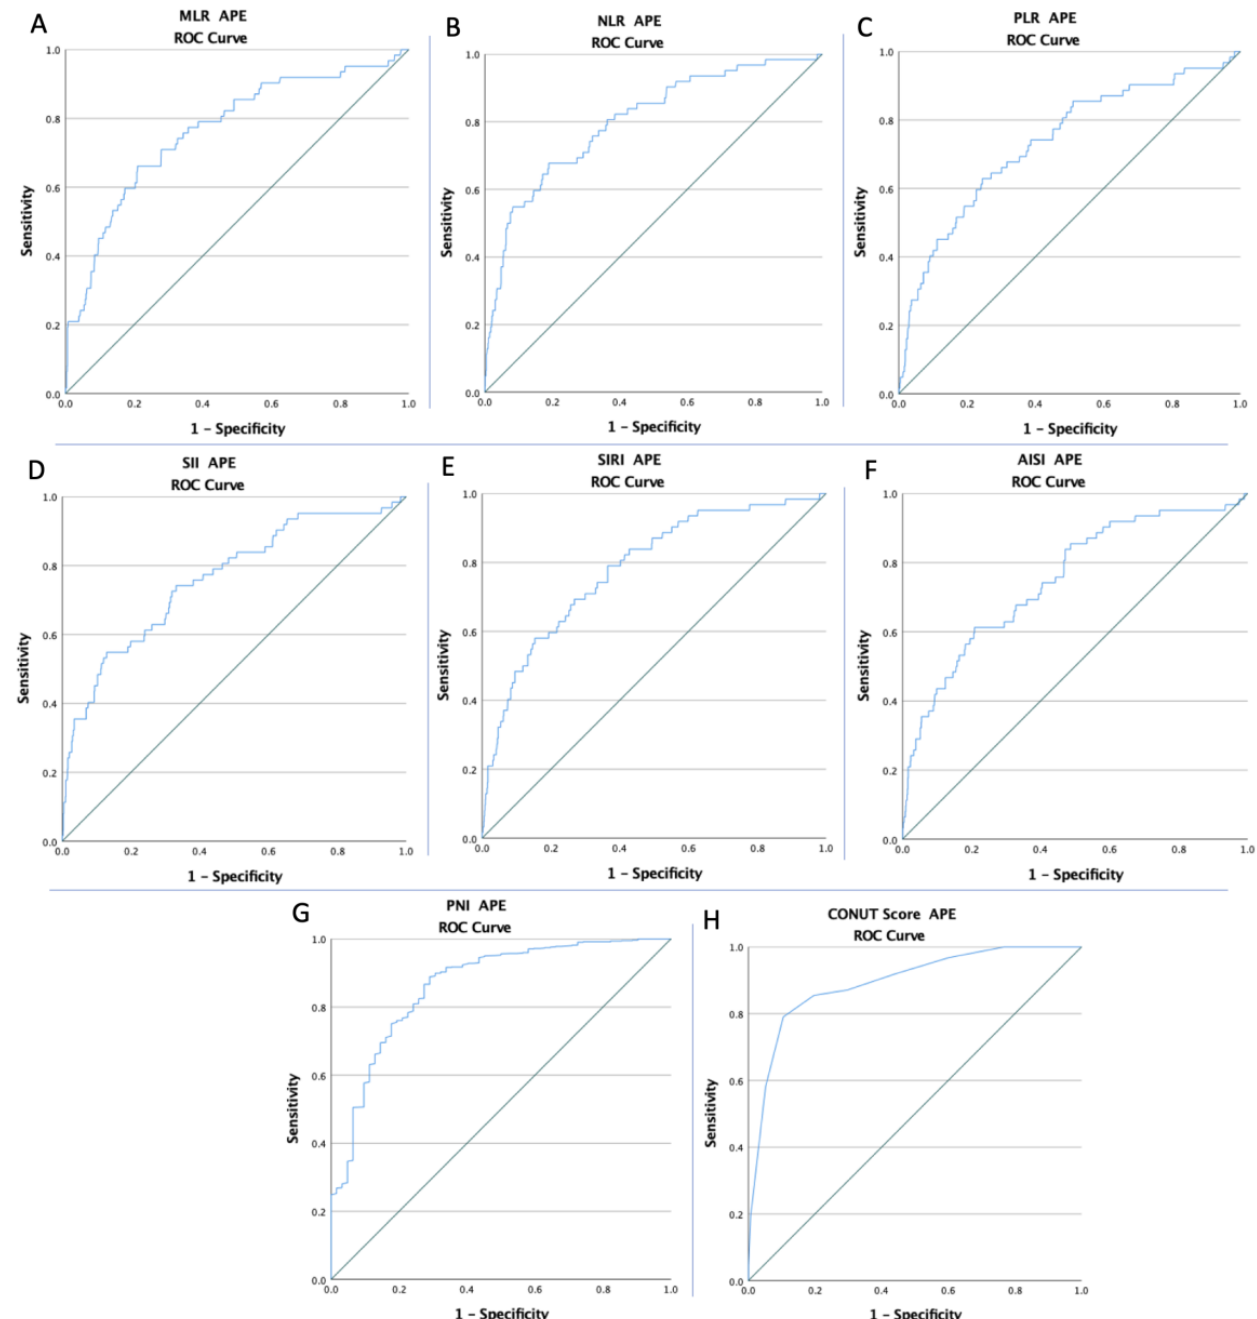
Figure 2. The ROC curve analysis concerning APE risk ( A ) for the MLR (AUC: 0.766; p < 0.0001), ( B ) for the NLR (AUC: 0.801; p < 0.0001), ( C ) for the PLR (AUC: 0.734; p < 0.0001), ( D ) for the SII (AUC: 0.761; p < 0.0001), ( E ) for the SIRI (AUC: 0.783; p < 0.0001), ( F ) for the AISI (AUC: 0.750; p < 0.0001), ( G ) for the PNI (AUC: 0.864; p < 0.0001), and ( H ) for the CONUT Score (AUC: 0.892; p < 0.0001).